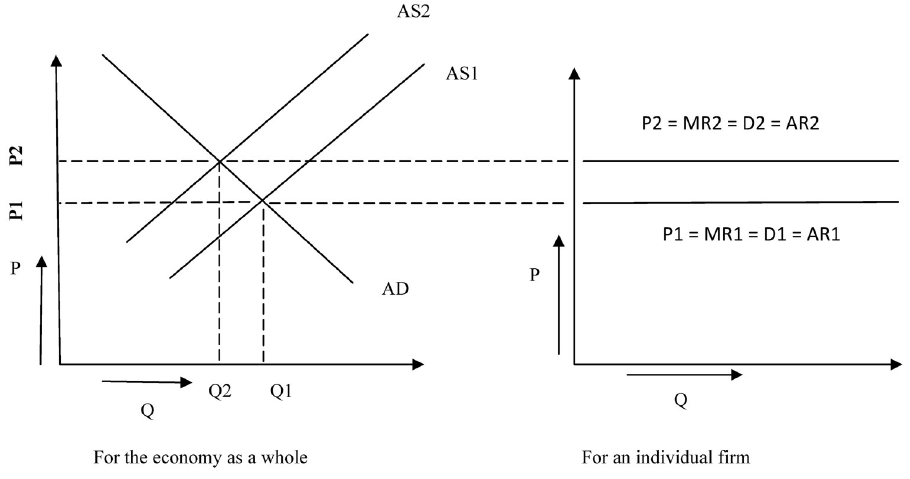
Fig 2. Impact of interest expense on macroeconomy and individual